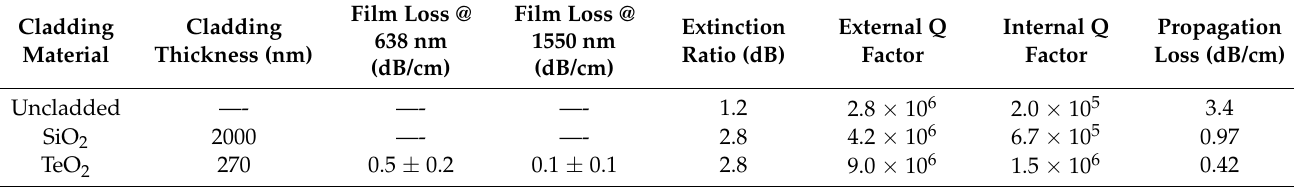
Figure 3. Measured TE transmission spectra for ( a ) uncoated, ( b ) SiO 2 -coated, and ( c ) TeO 2 -coated silicon microring resonators with a microring–waveguide gap of 1.0 μ m. Close-up views of the under-coupled resonances for the ( d ) uncoated, ( e ) SiO 2 -coated, and ( f ) TeO 2 -coated silicon microring resonators showing an intrinsic quality factor, Q i , of 1.5 × 10 6 , corresponding to 0.42 dB/cm optical propagation loss for the TeO 2 -coated silicon microring resonator. Table 1. Measured properties of silicon microring resonators with different cladding